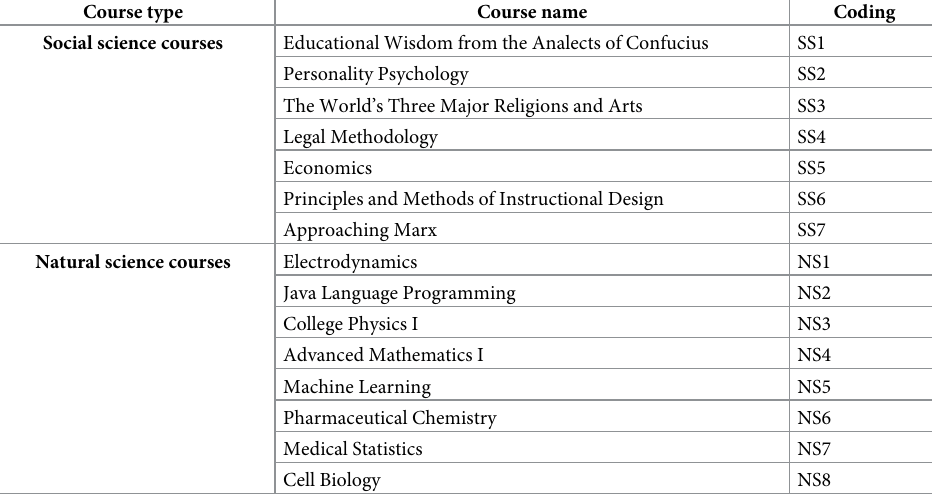
Table 1. List of the target